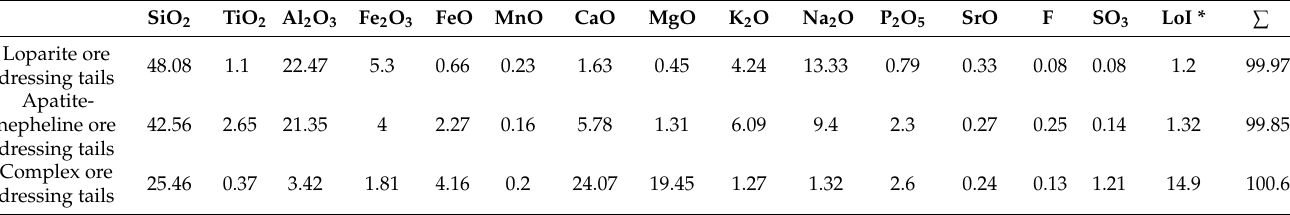
Table 5. The chemical composition of the ore dressing tails, weight